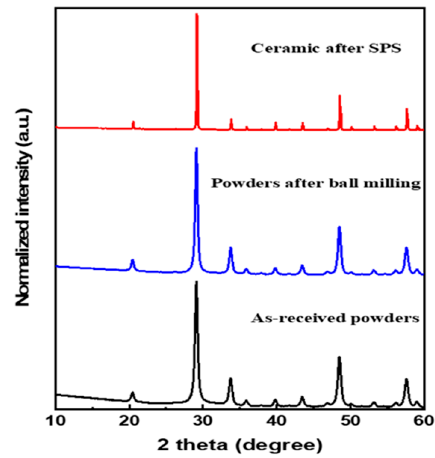
Figure 1. XRD patterns of Y 2 O 3 nanopowders with and without ball milling and the ceramic after ◦ SPS processing at 1250 °C. SPS processing at 1250